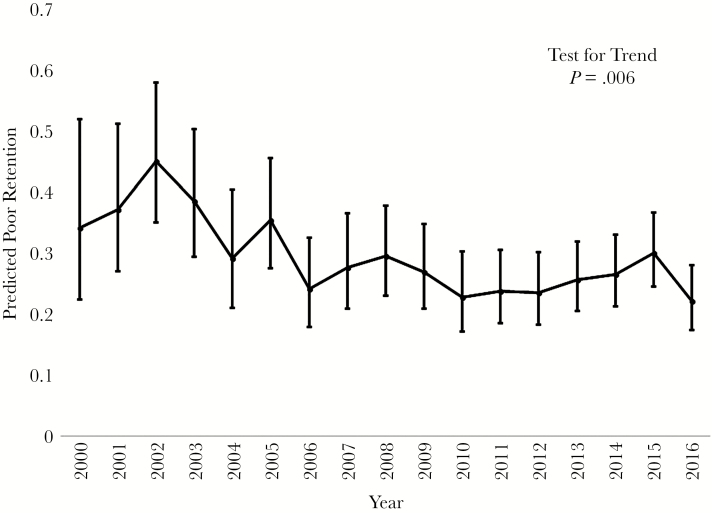
Predicted poor retention in care by year of study. Circles represent point estimates for predicted poor retention in care, and whiskers represent predictive margins for observed poor retention in care after the multivariable regression model.